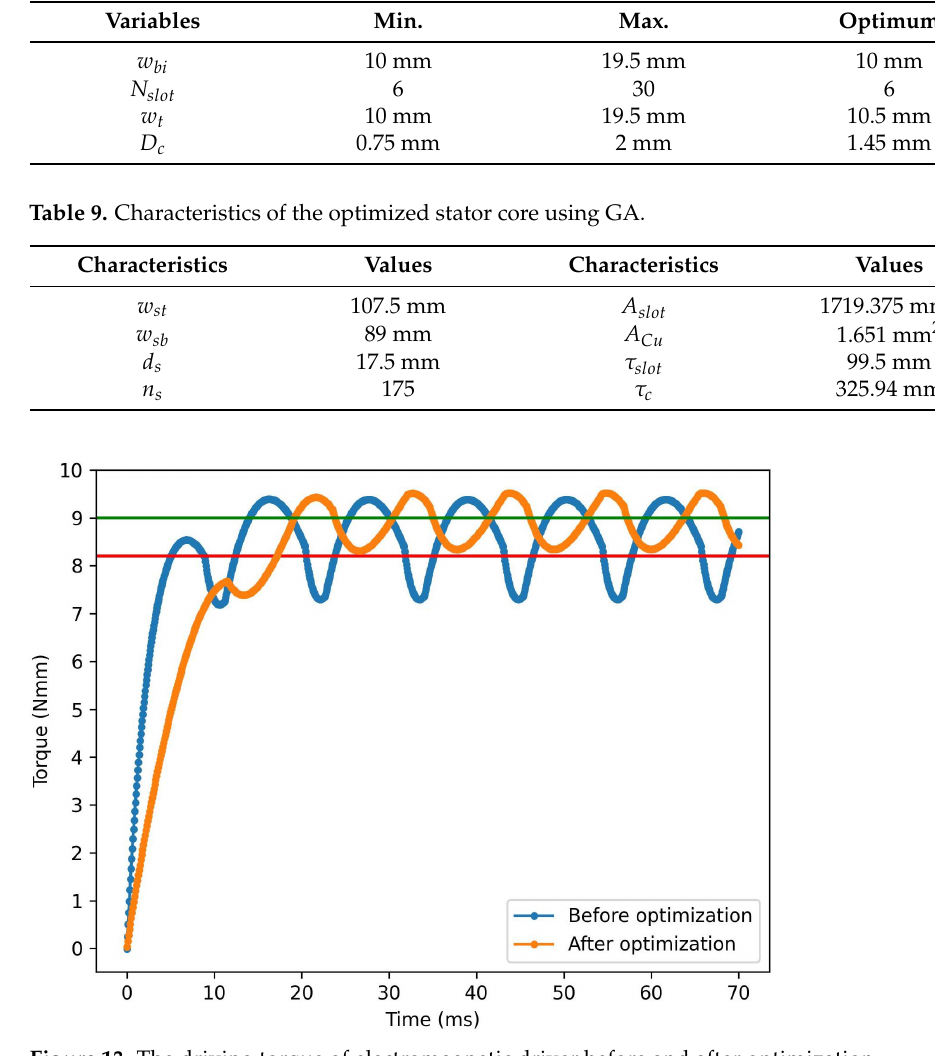
Figure 13. The driving torque of electromagnetic driver before and after